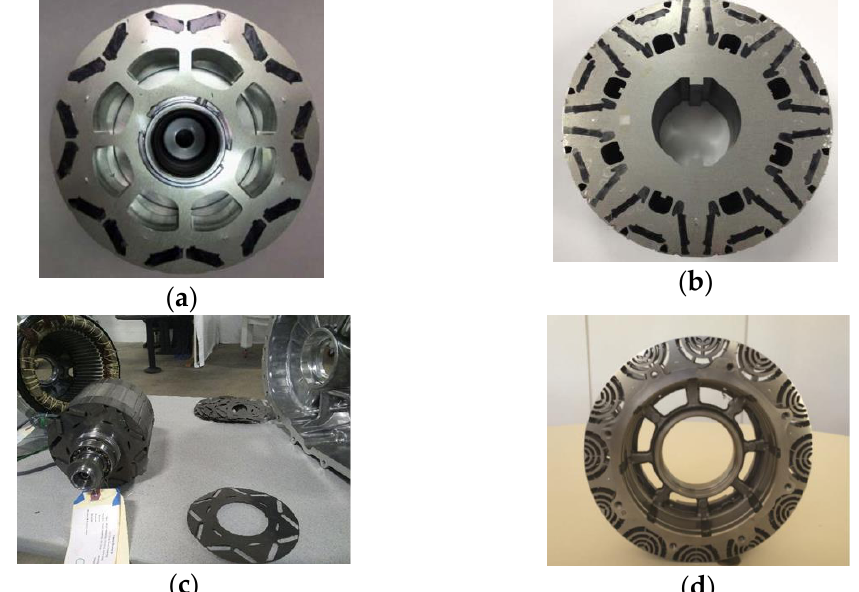
Figure 5. Rotor design of the interior permanent magnet (IPM) machine of production traction motors: ( a ) 2010 Prius [7] V-shaped rotor; ( b ) 2017 Prius double U rotor [8]. ( c ) 2017 Tesla Model 3 IPM V rotor [13], ( d ) 2016 Chevy Volt IPM rotor [22].